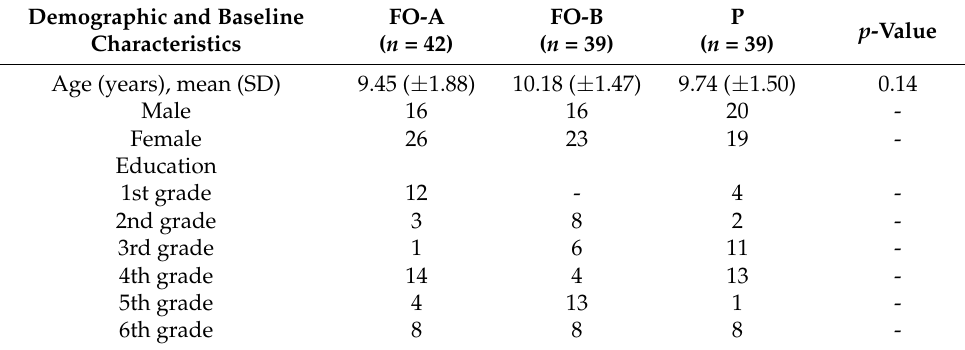
Table 1. The demographic data of participants. Demographic and Baseline